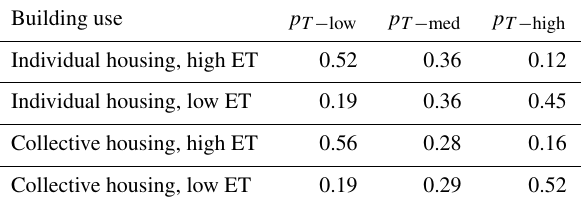
Table A6. Conditional probability that a household will heat to the low, medium and high design temperature as a function of its effi- ciency tendency (ET) class (high or low). The conditional probabil- ities are derived from the ENERGIHAB survey, the values for the design temperature are given in Table